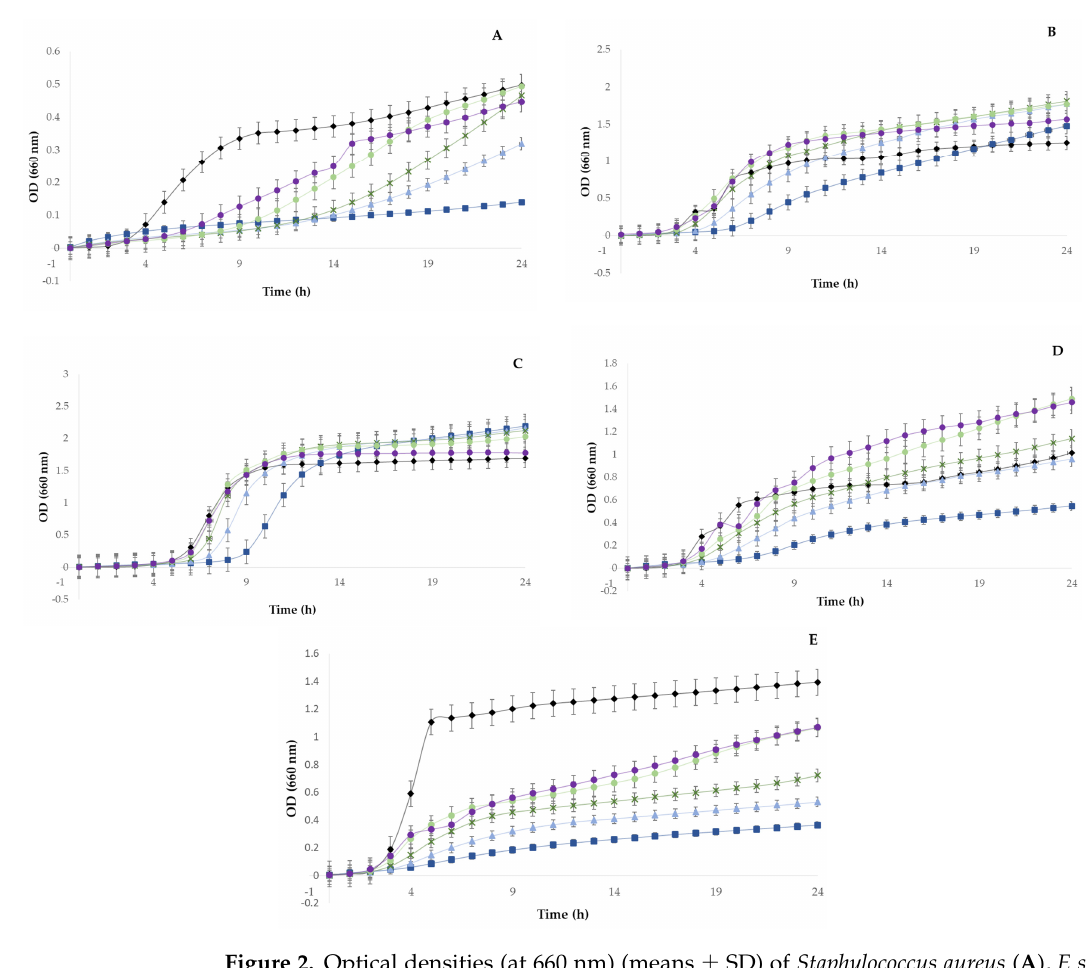
Figure 2. Optical densities (at 660 nm) (means ± SD) of Staphylococcus aureus (A), E scherichia coli (B), Pseudomonas aeruginosa (C), Salmonella enterica (D), and Bacillus cereus (E) when incubated with different concentrations of sugarcane straw polyphenolic extract: 10 mg/mL ( ○ ), 20 mg/mL ( ● ), 30 mg/mL (×), 40 mg/mL ( ▲ ), 50 mg/mL ( ■ ), and positive control ( ◆ ). All determinations were carried out in duplicate, and results are shown as mean ± standard deviation